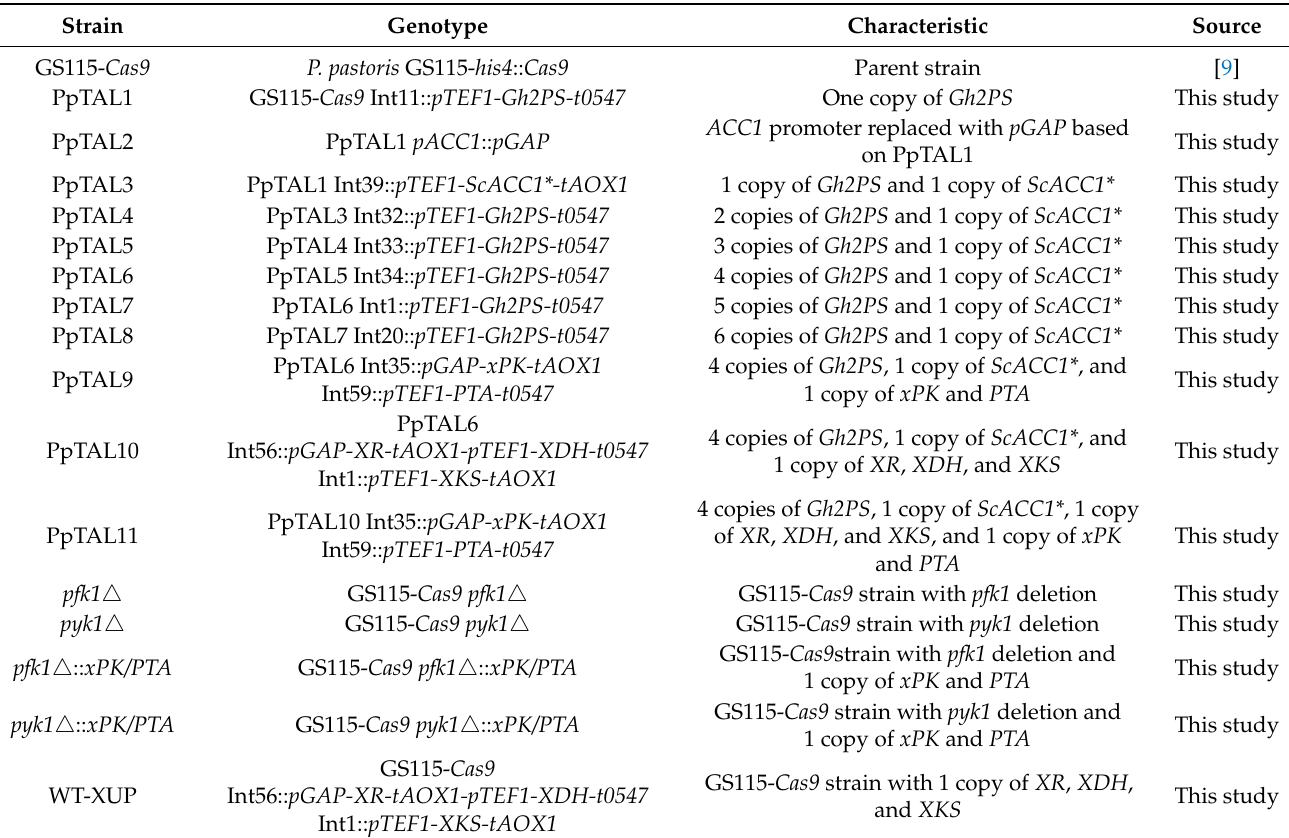
Table 1. Strains used in this